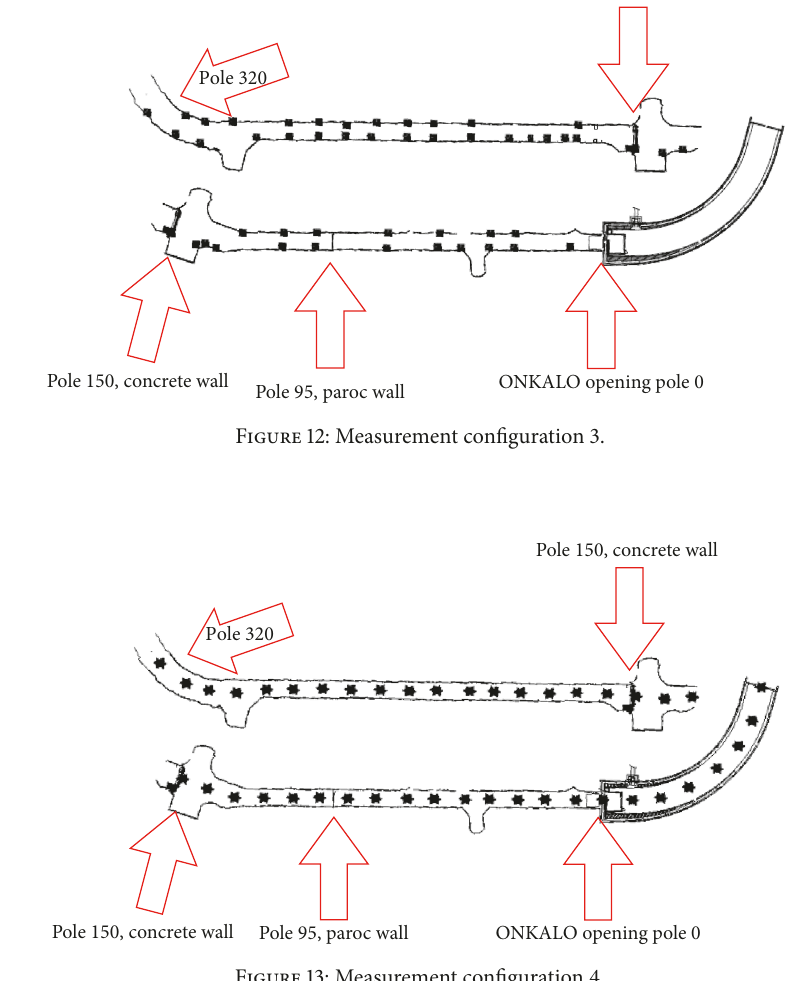
Figure 13: Measurement configuration